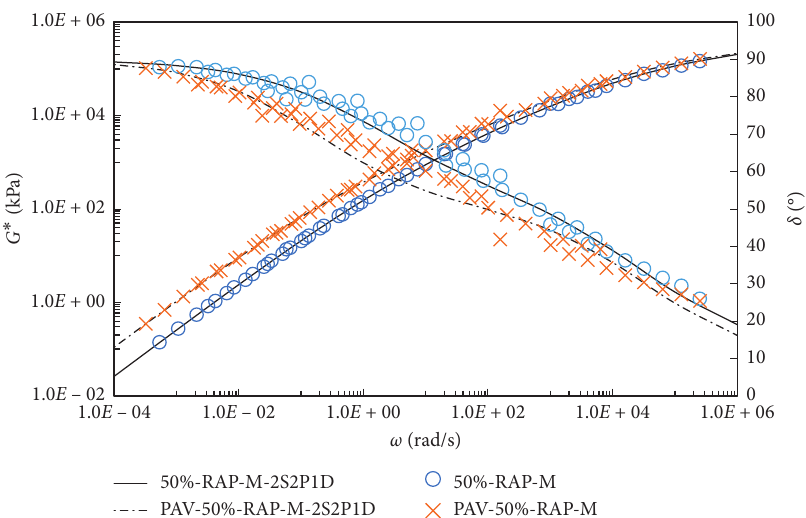
Figure 9: Complex shear modulus and phase angles master curves for RAP-M binder containing 50% RAP binder before and after PAV aging.